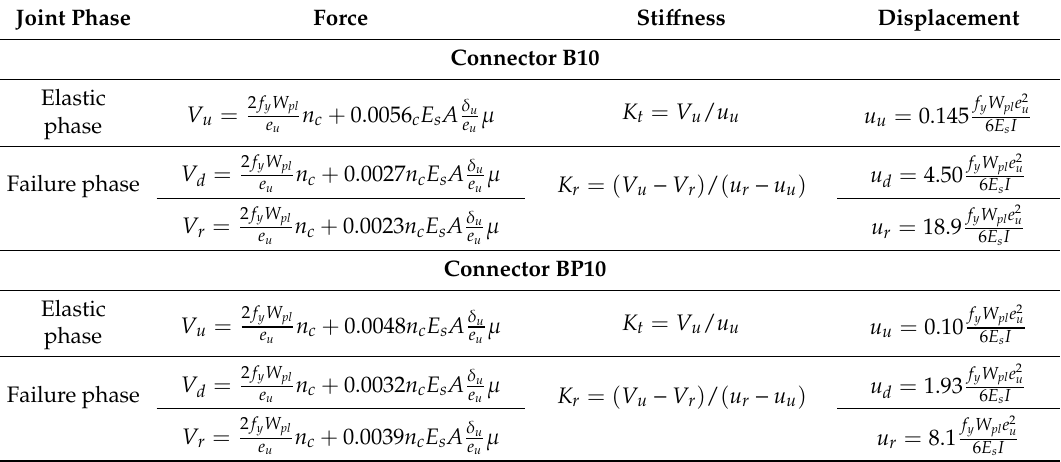
Table 13. Relationships expressing the work of reinforced joints in walls.